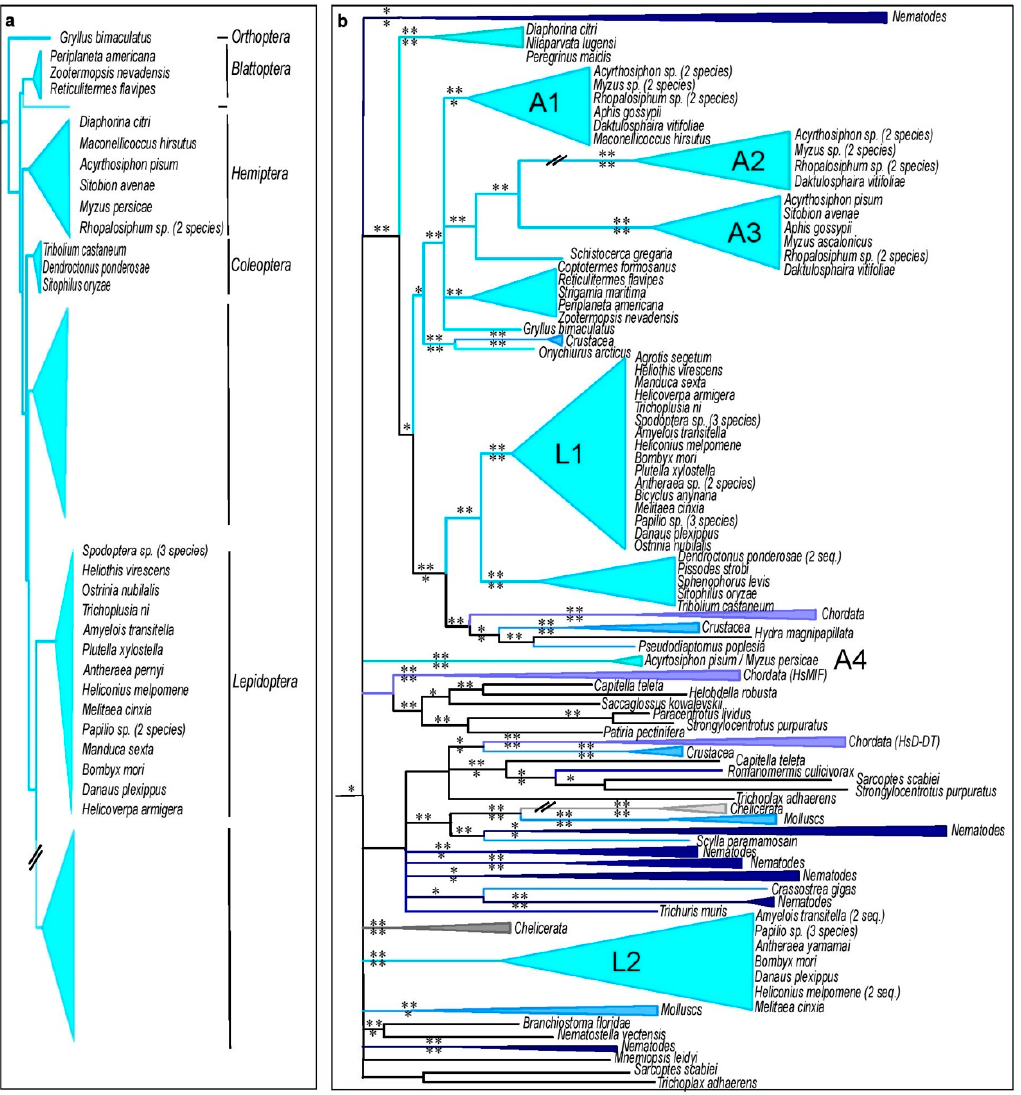
Figure 5. Insect species tree and corresponding MIF phylogeny. ( a ) BI tree topology based on insect 18S rRNA sequences. ( b ) BI tree topology for MIF sequences of the same species. The symbol // indicates that the respective branch does not follow the scale of the figure. Species and orders ( Diptera, Hymenoptera, and Phthiraptera ) lacking MIF sequences appear in grey. Colors of MIF clusters correspond to the species from which the MIF sequence originated. PP support values are indicated above the branch for the BI and corresponding aLRT support values below the branch for the ML analysis. *: PP > 0.5 or aLRT > 0.7. **: PP > 0.7 or aLRT > 0.9. The corresponding tree using the ML method is presented in Supplementary Figure S5b.